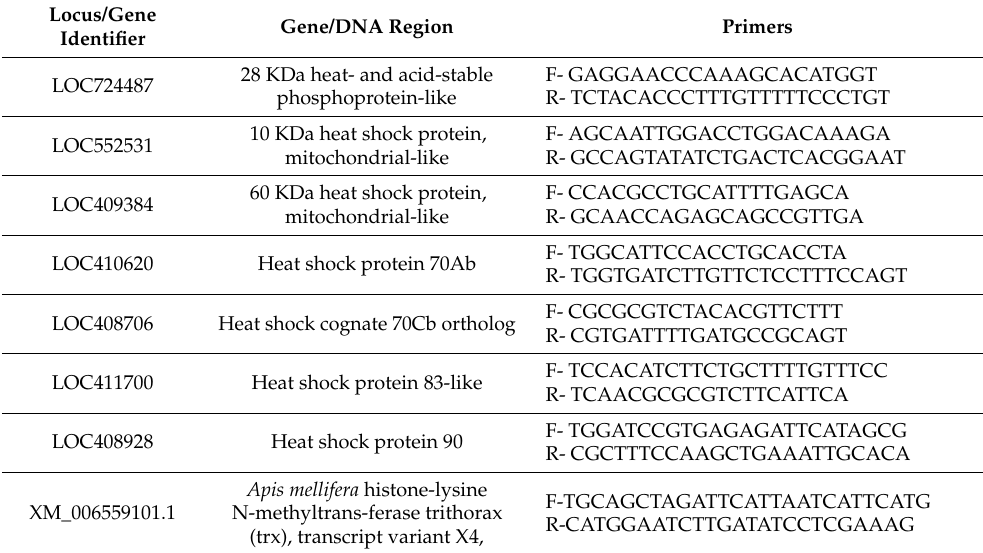
Table 1. Primer sequences with gene names, gene subcellular location, and NCBI gene ID for hsp , hsc/trx genes used in the present